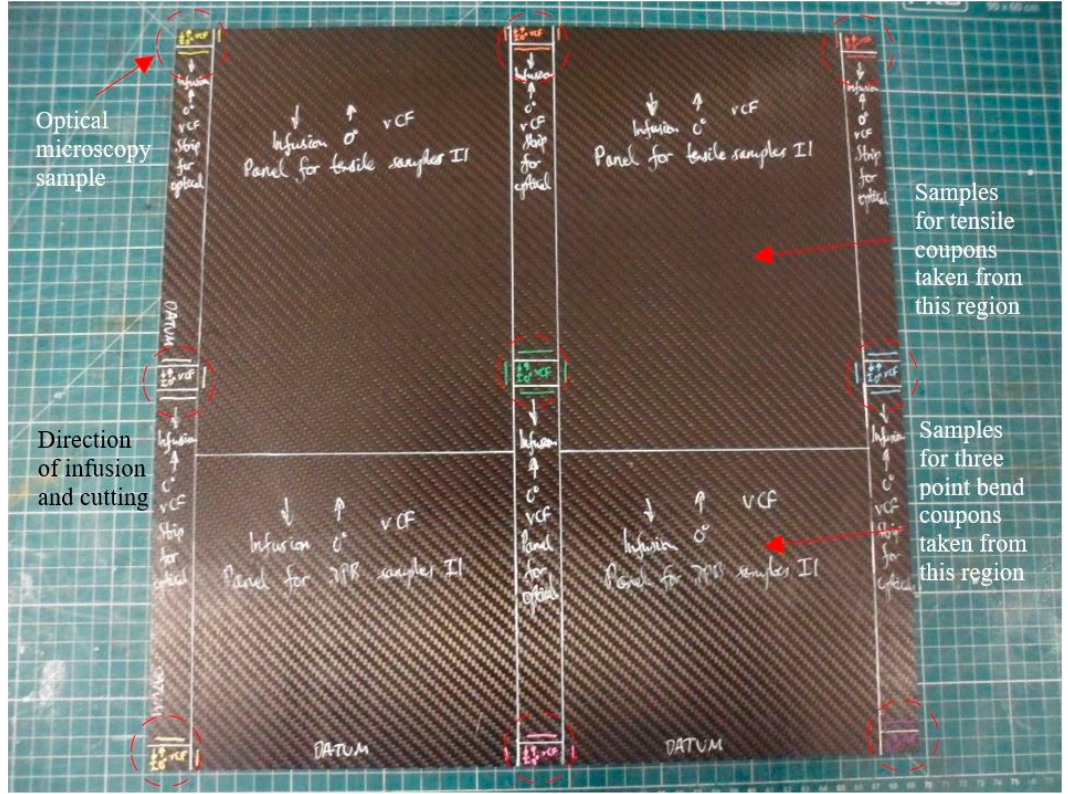
Figure 4. Virgin carbon fiber panel prepared for cutting into coupons and optical microscopy samples following the completion of experimental modal analysis.